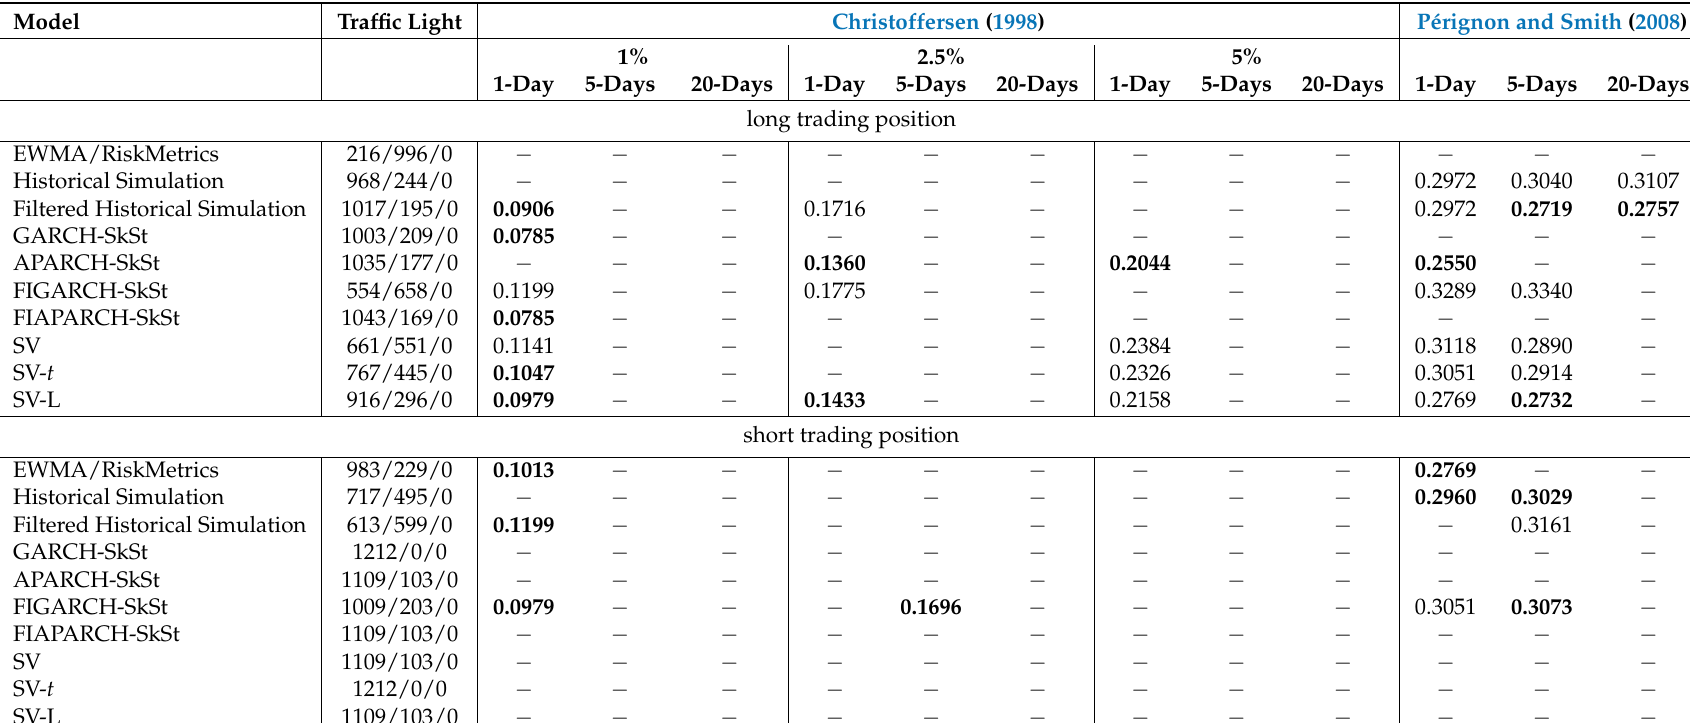
Table 4. Value-at-Risk backtest results for PCOMP